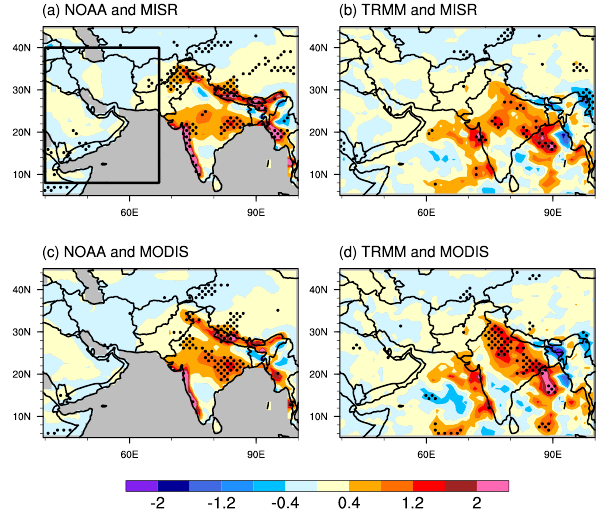
Figure 4. Spatial patterns of AOD regressed on area-averaged ISM rainfall in WHI (box in a ) using JJA monthly anomalies from 2000 to 2013. Two different AOD data sets (MISR and MODIS Terra) and two different rainfall data sets (NOAA and TRMM) are used, so there are four different results. The black dots represent grid points that have a 95% confidence level based on the t test. Missing values are marked out in gray.